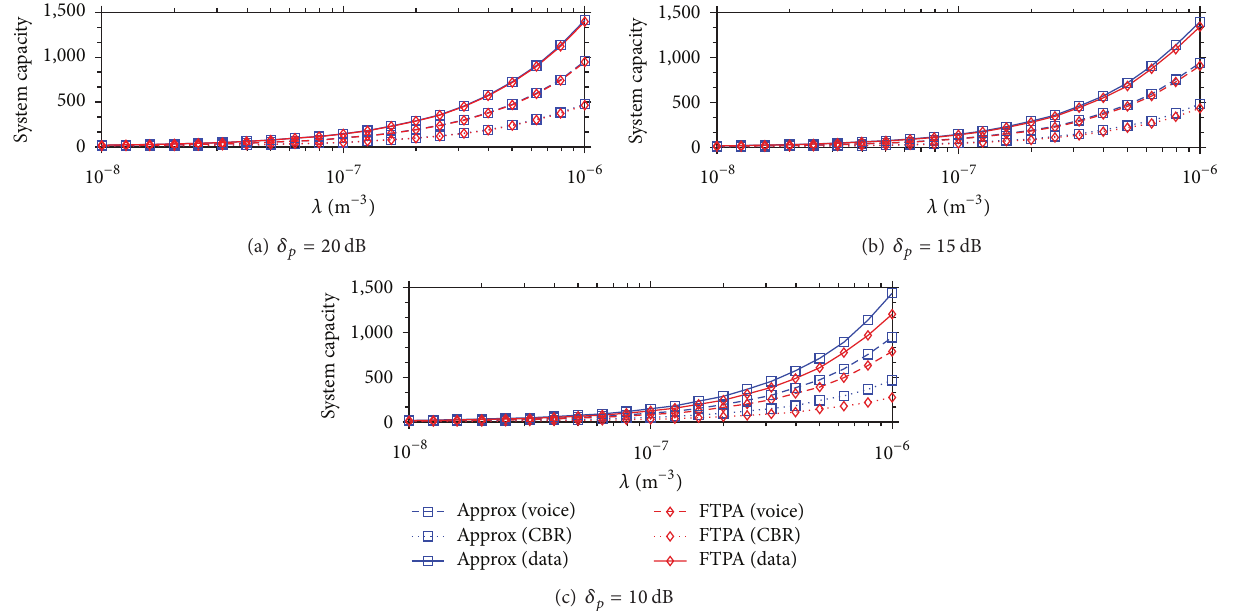
Figure 8: Aggregate system capacity achieved by FTPA and Approx versus the FBS deployment density under different 𝛿 𝑝 .